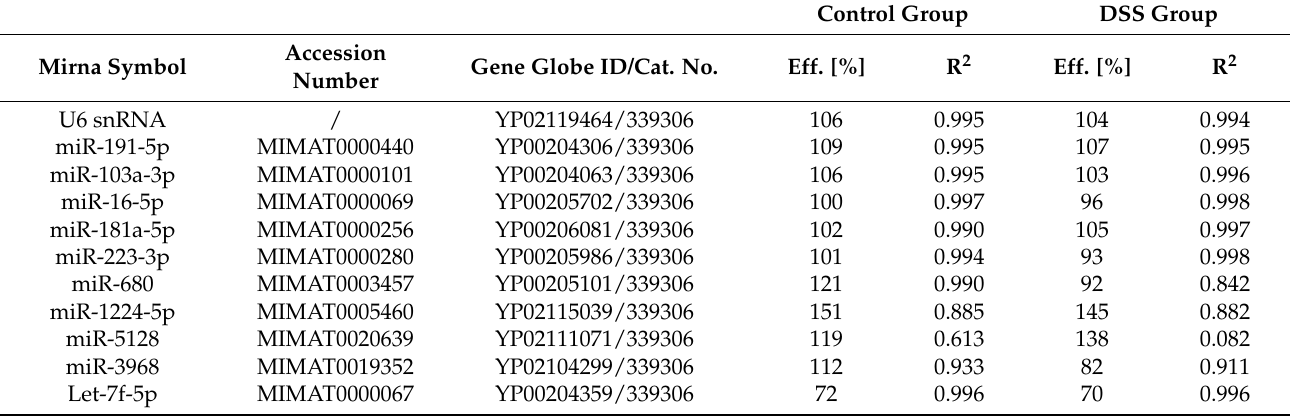
Table 2. Information on miRNA candidate reference genes and target genes and their qPCR amplifi- cation characteristics in archived FFPE colon samples of control and DSS-treated C57BL6/JOlaHsd mice. Legend: Eff., amplification efficiency; R2, correlation